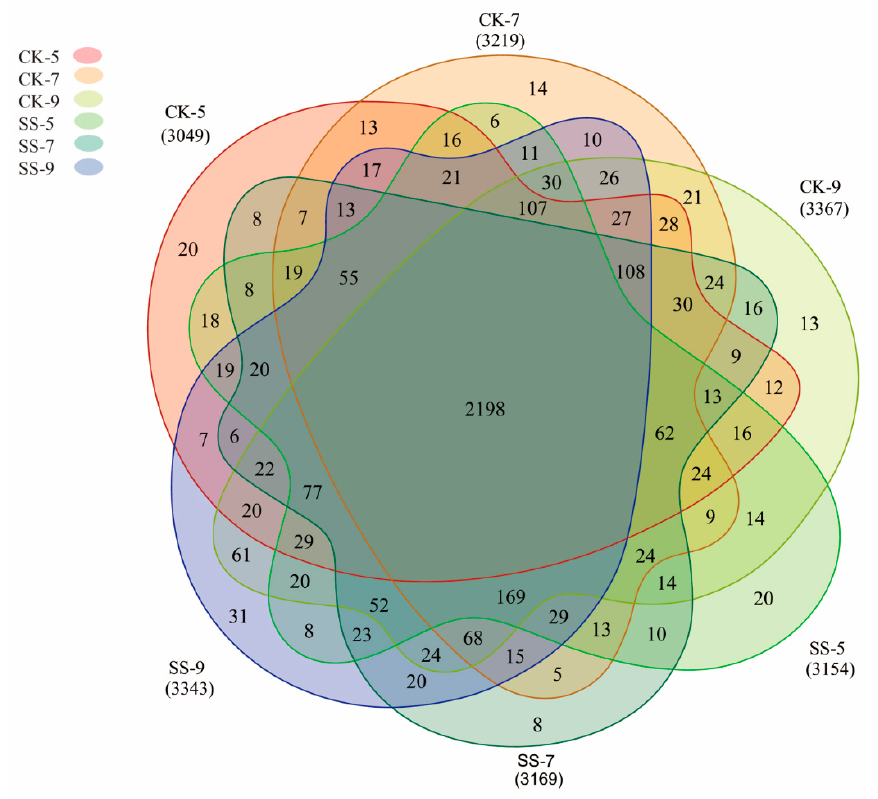
Figure 3. Venn diagram showing the shared operational taxonomic units (OTUs) of CK-5, CK-7, CK-9, SS-5, SS-7, and SS-9. CK: Control, soil of non-infected P. sylvestris var. mongolica ; SS: treatment, soil of infected P. sylvestris var. mongolica ; May, July, and September represent spring, summer, and autumn, respectively.